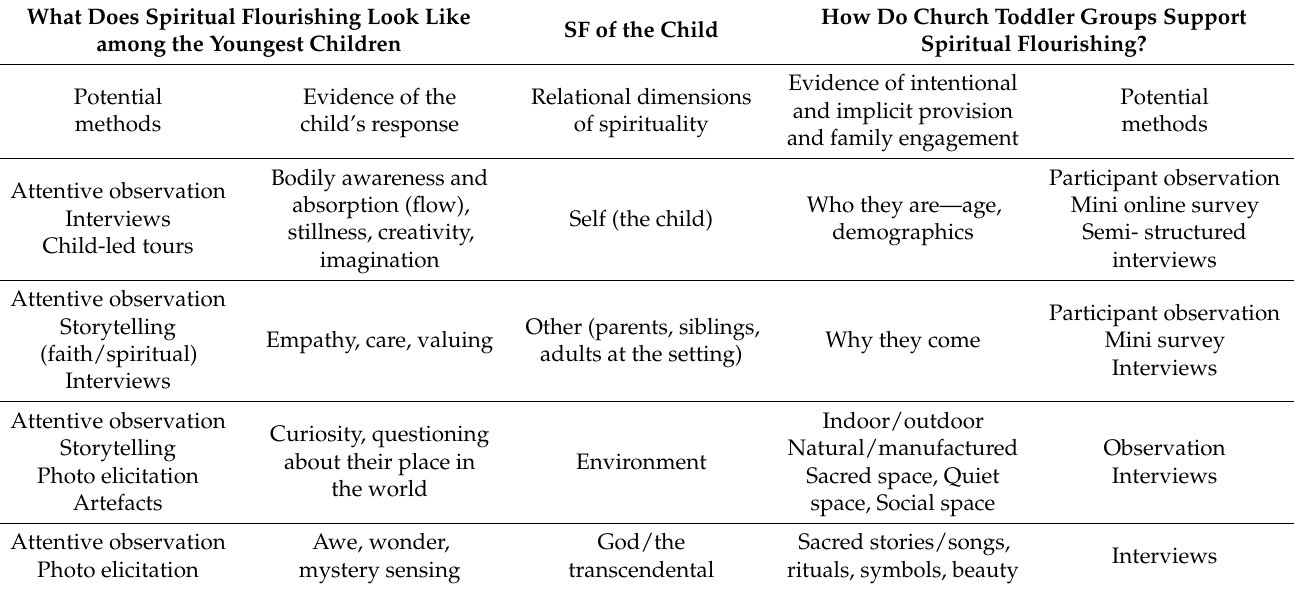
Table 2. Research framework—Spiritual Flourishing (SF) in church toddler groups